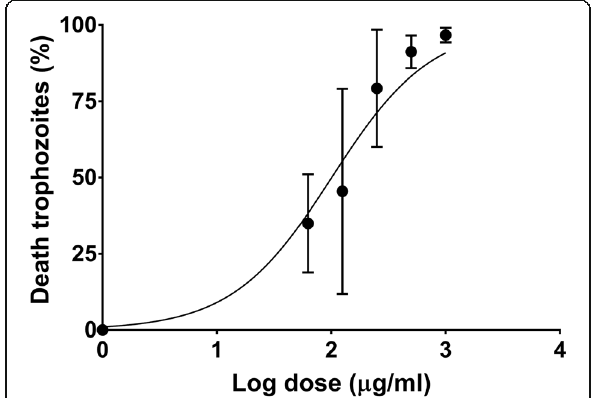
Fig. 4 Antigiardial activity of Palythoa cariboeroum whole extract